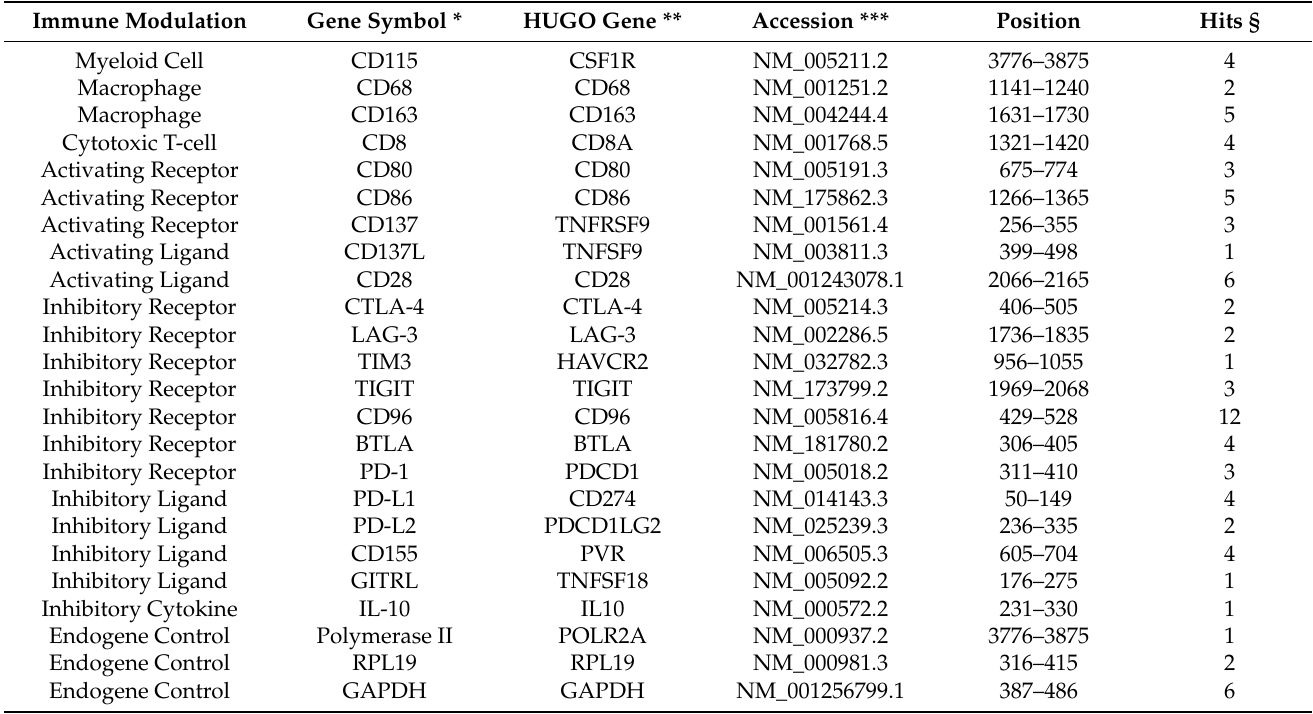
Table 1. nCounter PlexSet Design and Isoform Coverage. * Name/alternative gene symbol; ** HUGO gene by HGNC = HUGO Gene Nomenclature Committee; *** used for probe design; § number of isoforms detected by the